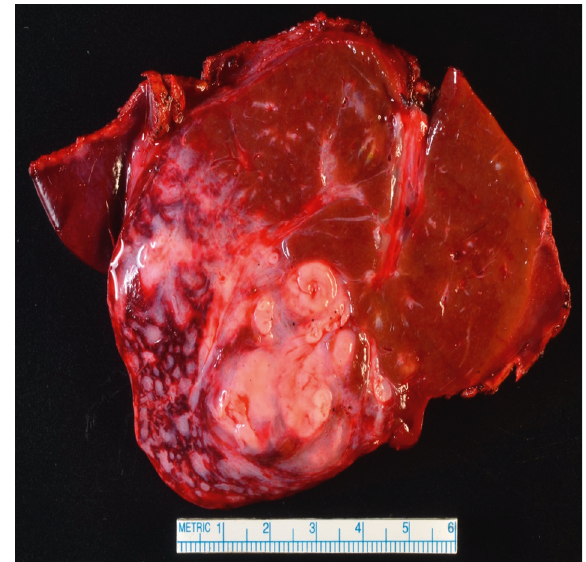
Figure 2: Gross specimen, resected tumor.